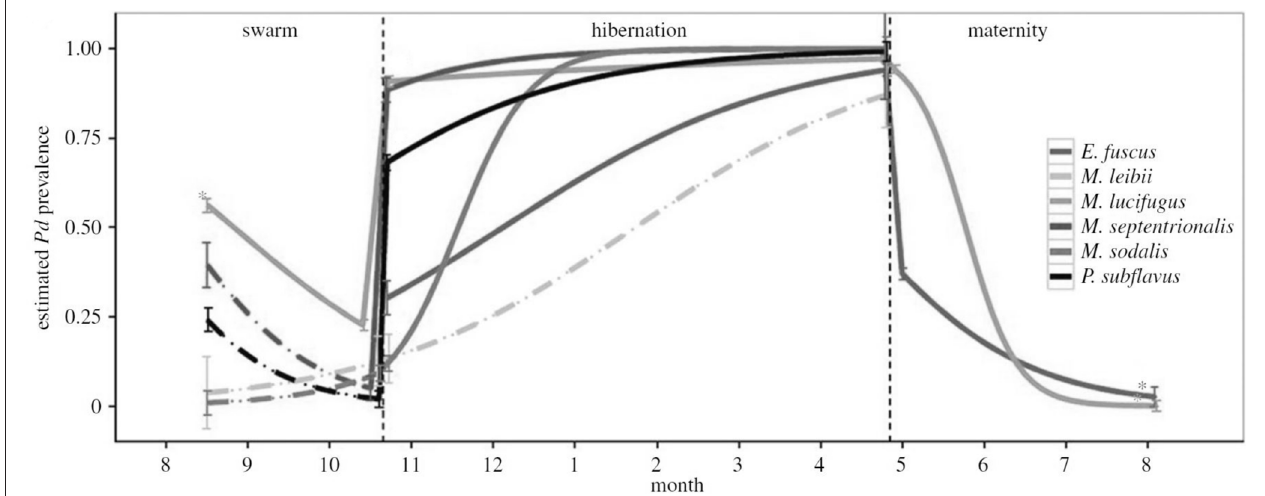
figURe 7 | Model results showing that the peak predicted prevalence (mean ± SE) of white nose virus ( Pseudogymnoascus destructans ) for six species of bats coincides with onset of hibernation. [Adapted from ( 12 ), with the permission of The Royal Society]